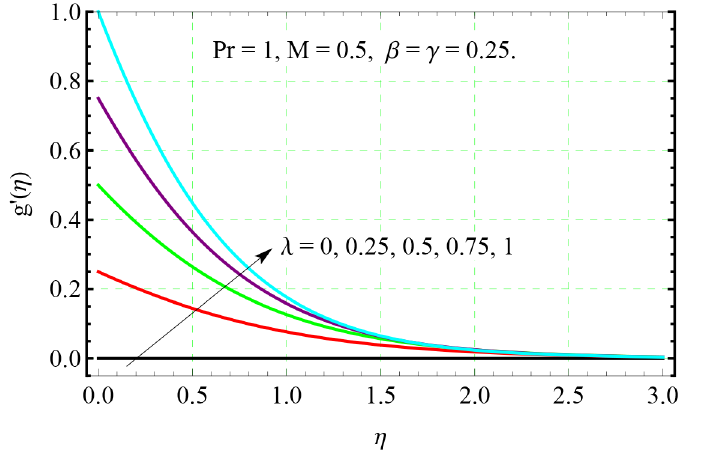
Fig 6. Effect of λ on g 0 ( η